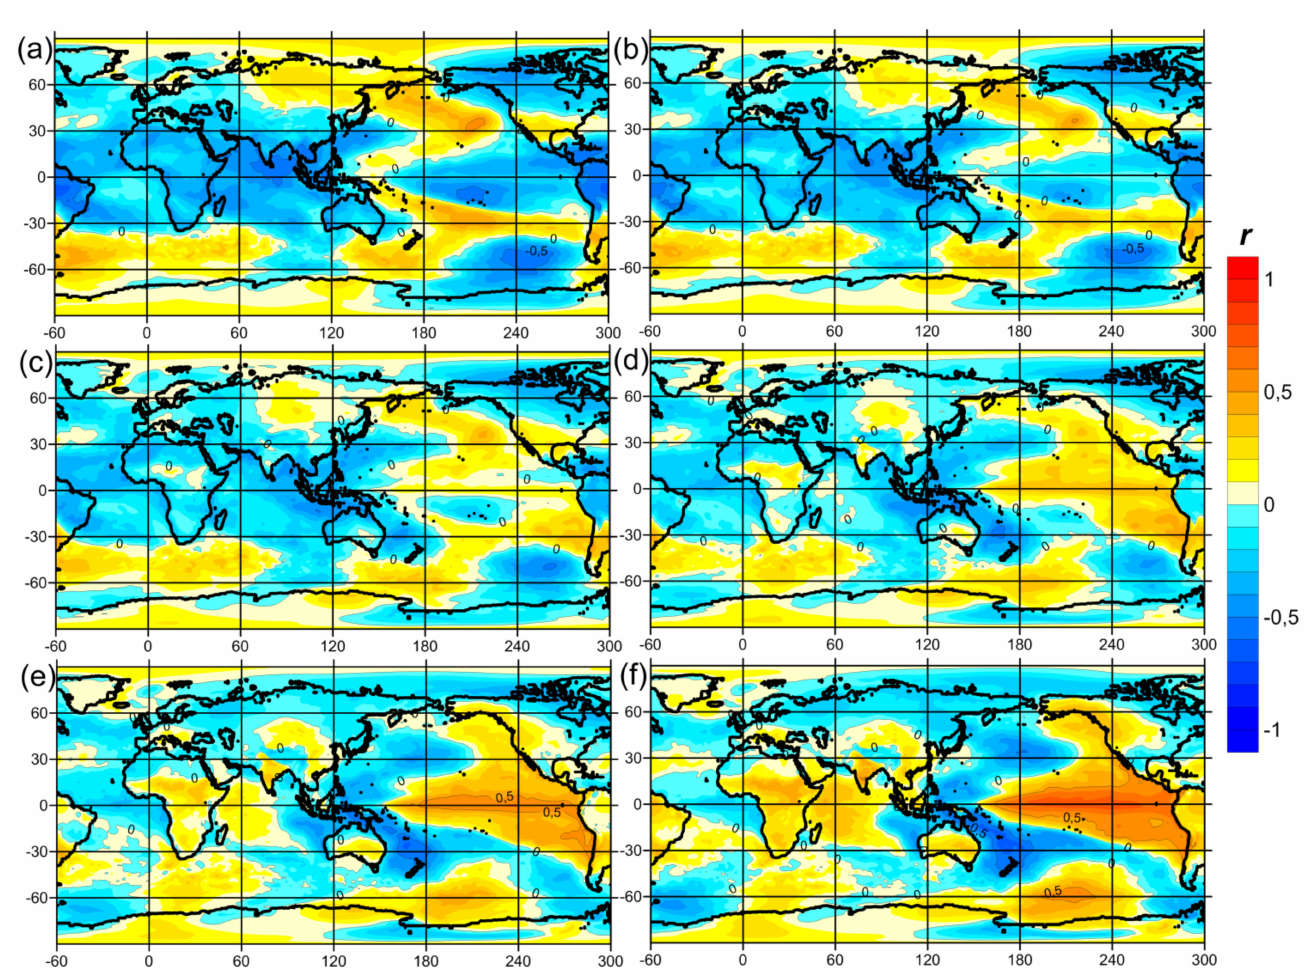
Figure 11. Cross-correlations between 14-month ( a ), 12-month ( b ), 10-month ( c ), 8-month ( d ), 6-month ( e ) and 4-month ( f ) shifts in air temperature anomalies at a height of 2 m from the surface and the Global Atmospheric Oscillation Index (GAO2) with band-pass filtering from 2 to 7